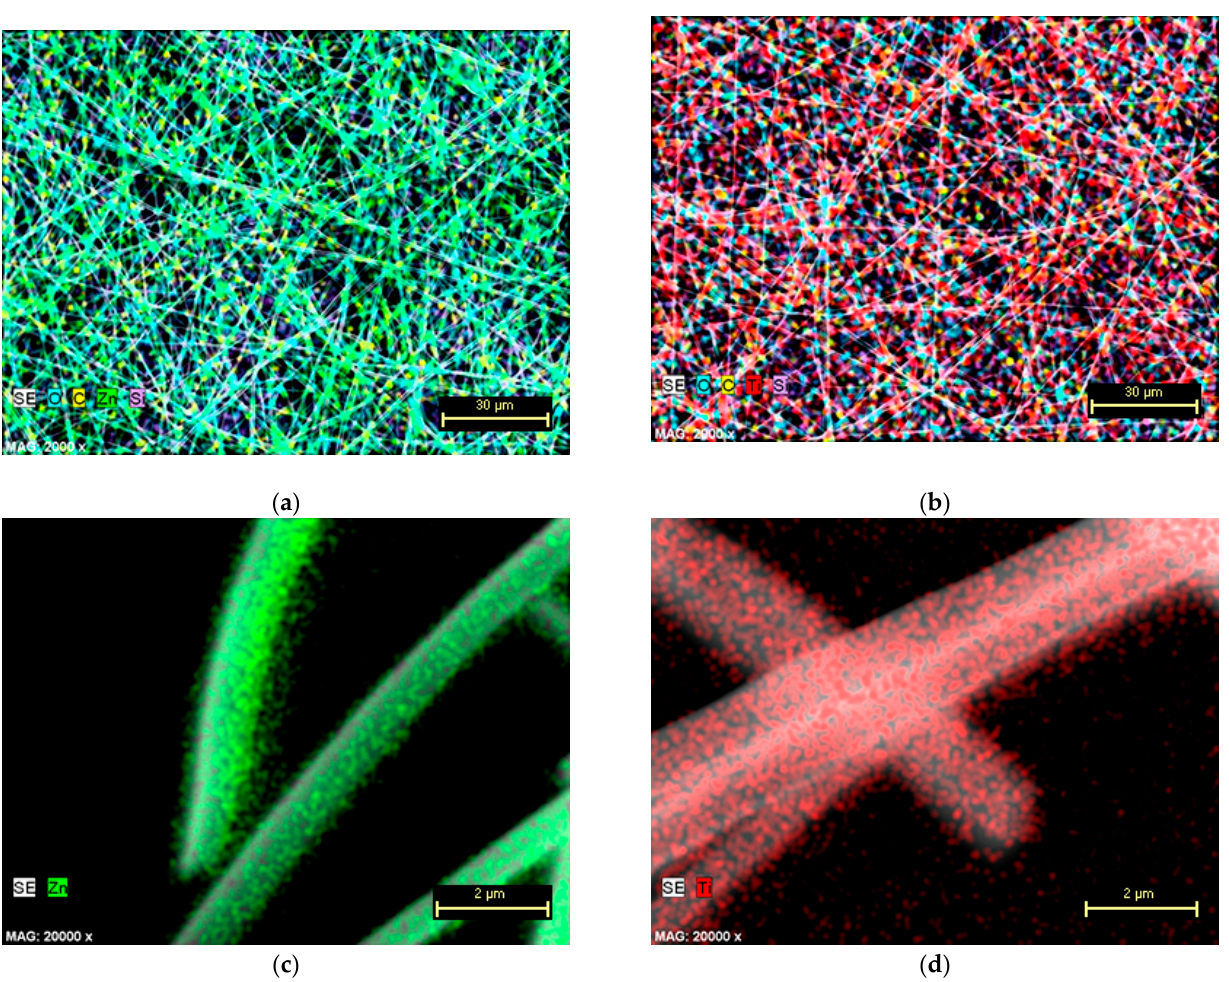
Figure 4. EDX maps at different magnifications showing the uniform distribution of the chemical elements in the ( a,c ) ZnO nanotubes and ( b,d ) TiO 2 nanotubes after the removal of PMMA electrospun template by calcination.